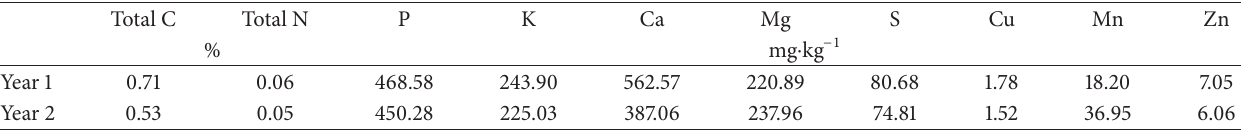
Table1:SoilsanalysisresultsforresearchplotsatCherryResearchStationnearGoldsboro,NC(year1),andtheLakeWheelerFieldLaboratory near Raleigh, NC (year 2). Analysis provided by the Environmental and Agricultural Testing Service at North Carolina State